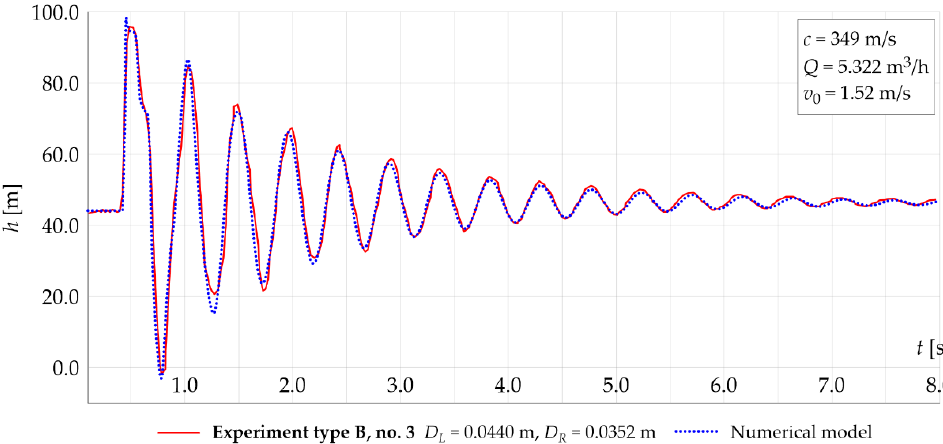
Figure 6. Calculated and observed pressure oscillations during experiment no. 3.